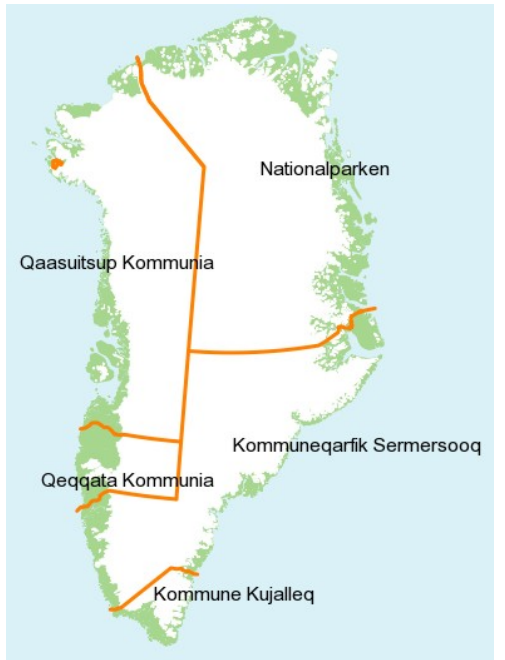
Figure 4: Greenland’s municipality names and borders